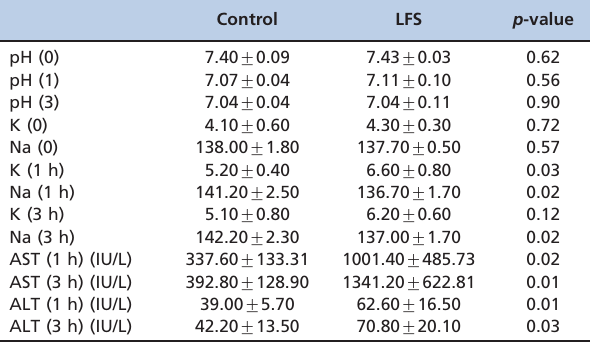
Table 3 - Results of serum analyses.